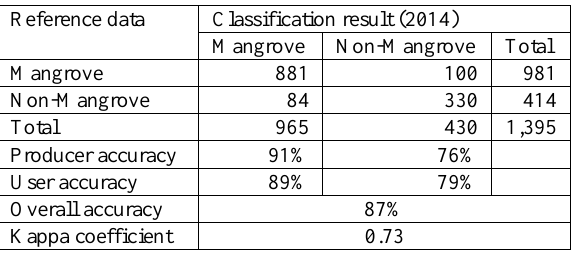
Table 2. The error matrix for classification results in 2014 comparing with ground reference map in 2011 with some modifications by the author.